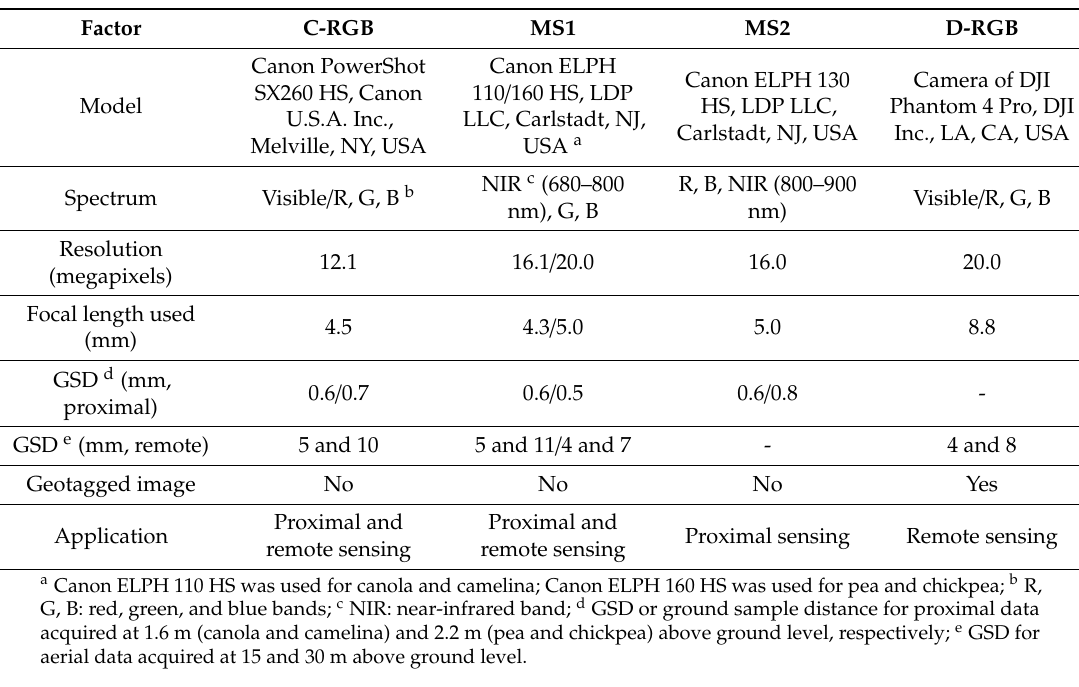
Table 2. Summary of sensors used in proximal and remote sensing.